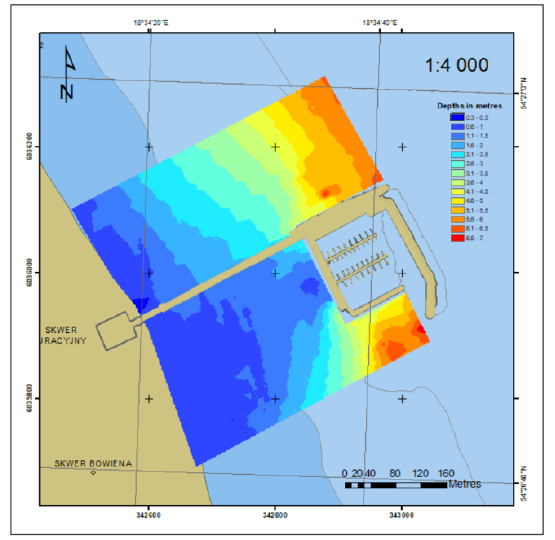
Figure 12. 2D bottom model based on the SBES surveys in 2018.